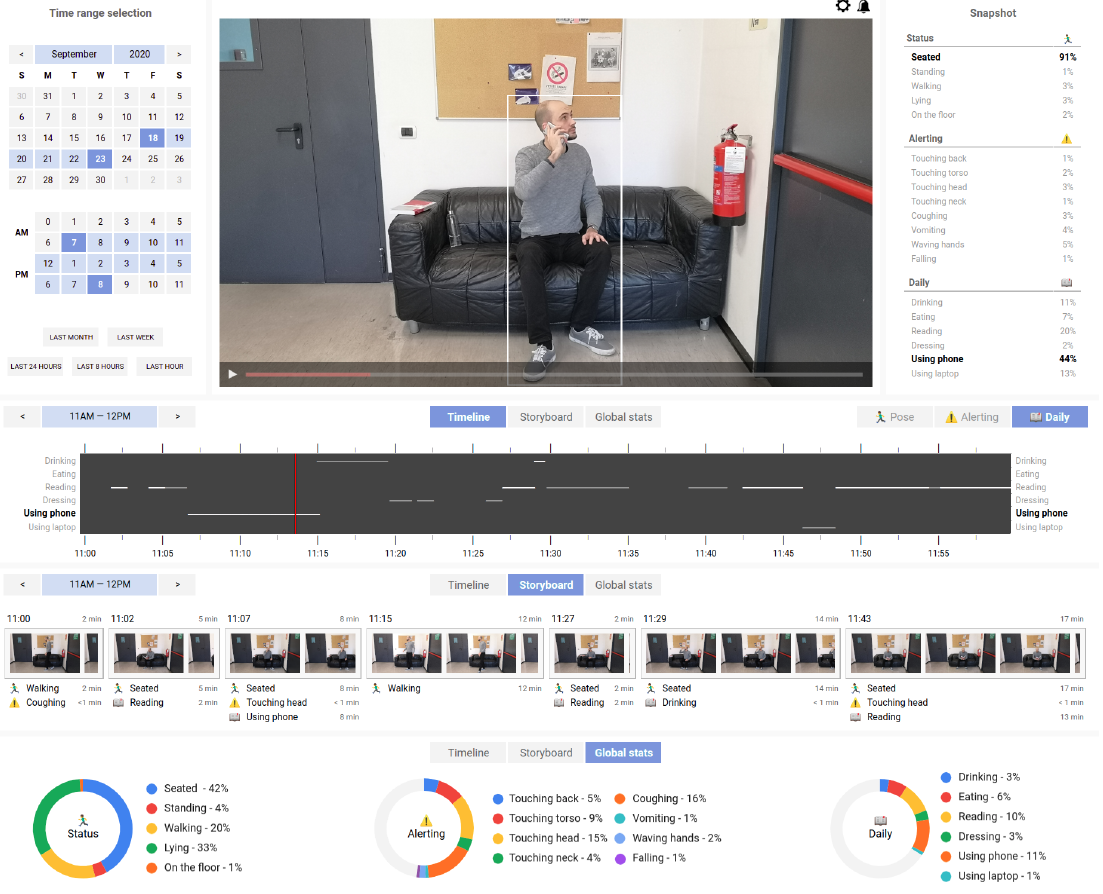
Figure 9. Interface of the client-side web application. After the time period of interest is selected, the registered actions can be browsed and visualized using different modalities: in a timeline, as a visual storyboard, or as global statistics. The user can also setup alarms to be automatically